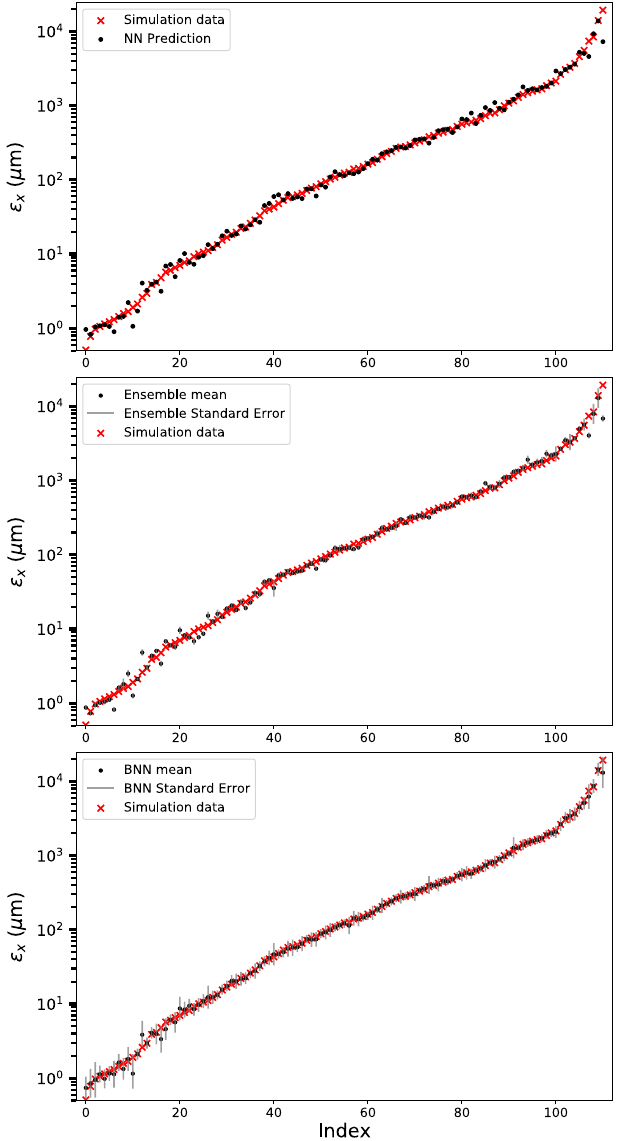
FIG. 4. Deterministic neural network predictions; Ensemble and Bayesian neural network model mean predictions and predicted standard error for LCLS-II injector front end simulation data.